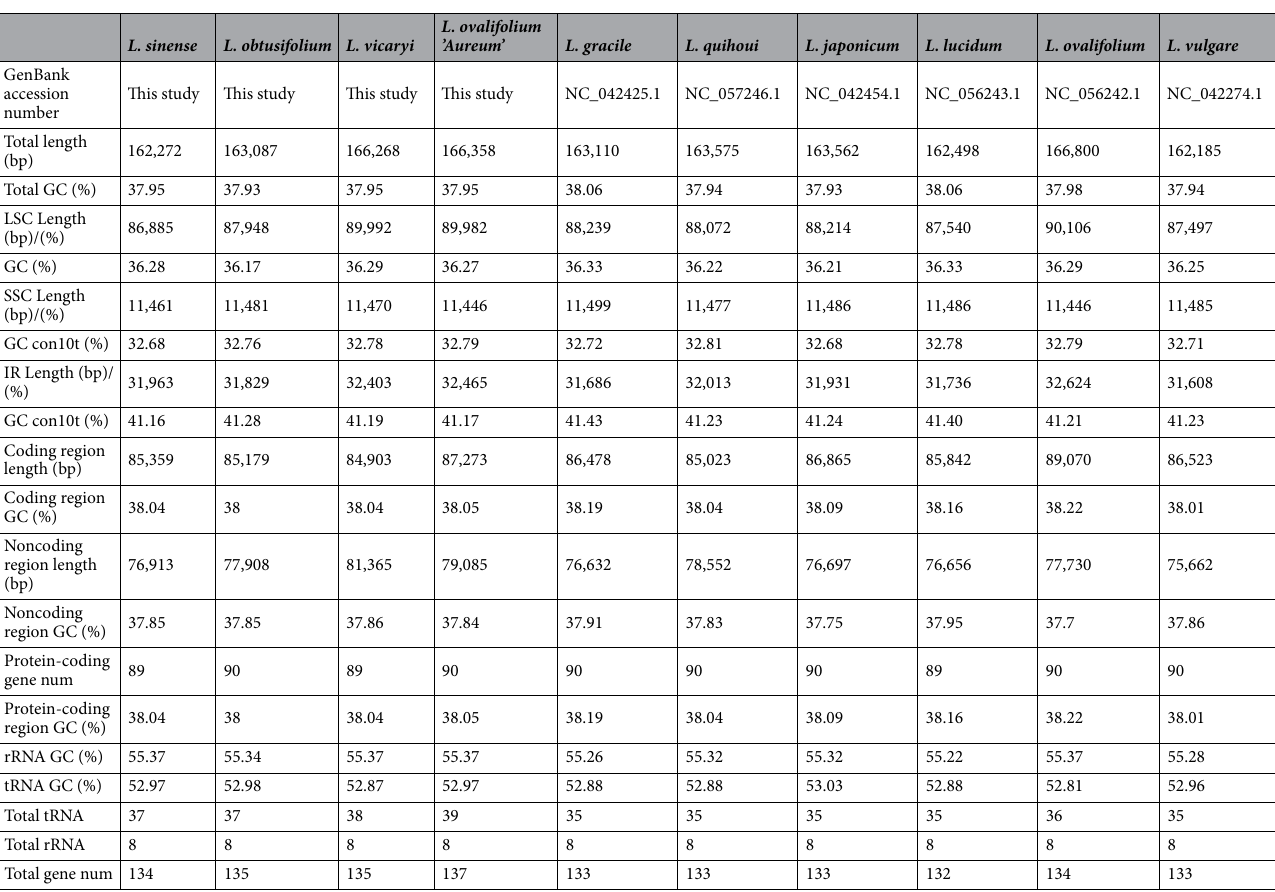
Table 1. The basic characteristics of the chloroplast genomes of ten Ligustrum species.